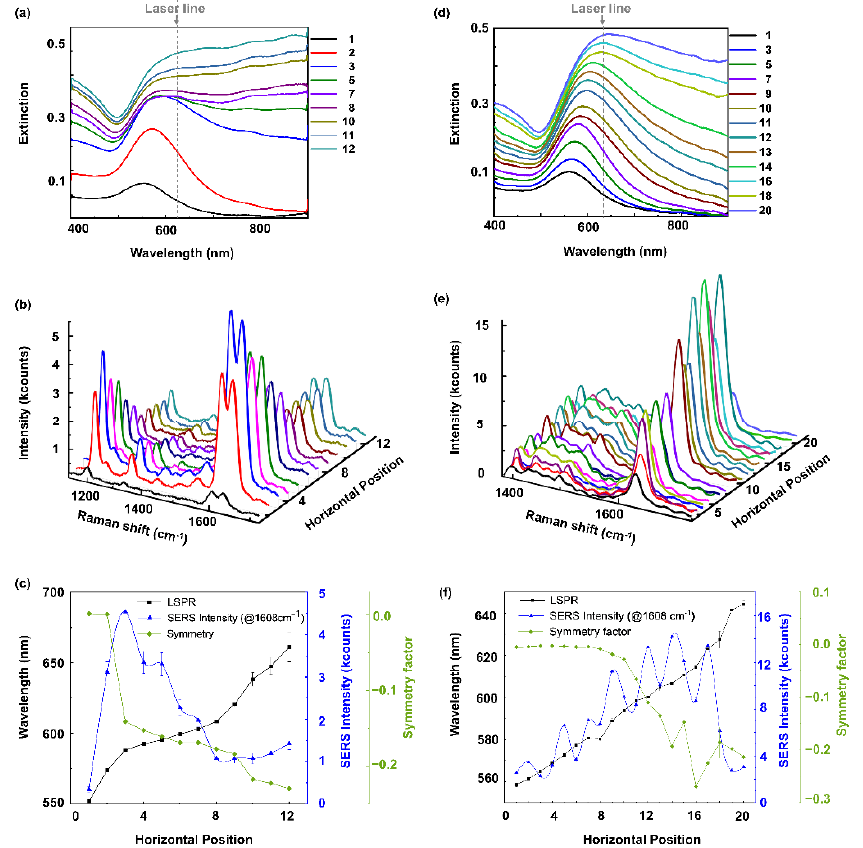
Figure 3. ( a ) Extinction spectra acquired (without analyte) at 12 lateral positions across the substrate used for SERS of BPE. ( b ) Raman spectra of BPE (1 µ L—0.25 × 10 − 3 M) acquired at the same 12 positions. ( c ) SERS intensity of BPE (@1608 cm − 1 )—blue curve, spectral maxima of the extinction spectra shown in ( a )—black curve, symmetry factor of the extinction spectra shown in ( a )—green curve, ( d ) Extinction spectra acquired (without analyte) at 20 lateral positions across another gradient SERS substrate used for MB. ( e ) Raman spectra of MB (1 μ L—0.25 × 10 − 3 M) acquired at the same 20 positions. ( f ) SERS intensity of MB (@1625 cm − 1 )—blue curve, spectral maxima of the extinction spectra shown in ( d )—black curve, symmetry factor of the extinction spectra shown in ( d )—green curve.